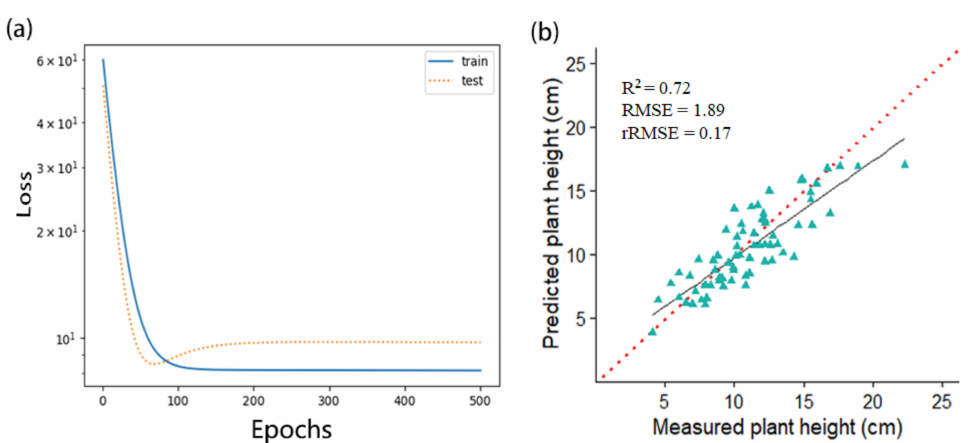
Figure 5. The change curve of the loss function with the number of iterations ( a ), correlations between the measured truth plant height and the predicted height ( b ) estimated by the simple linear regression (SLR) model using the RGB-D depth